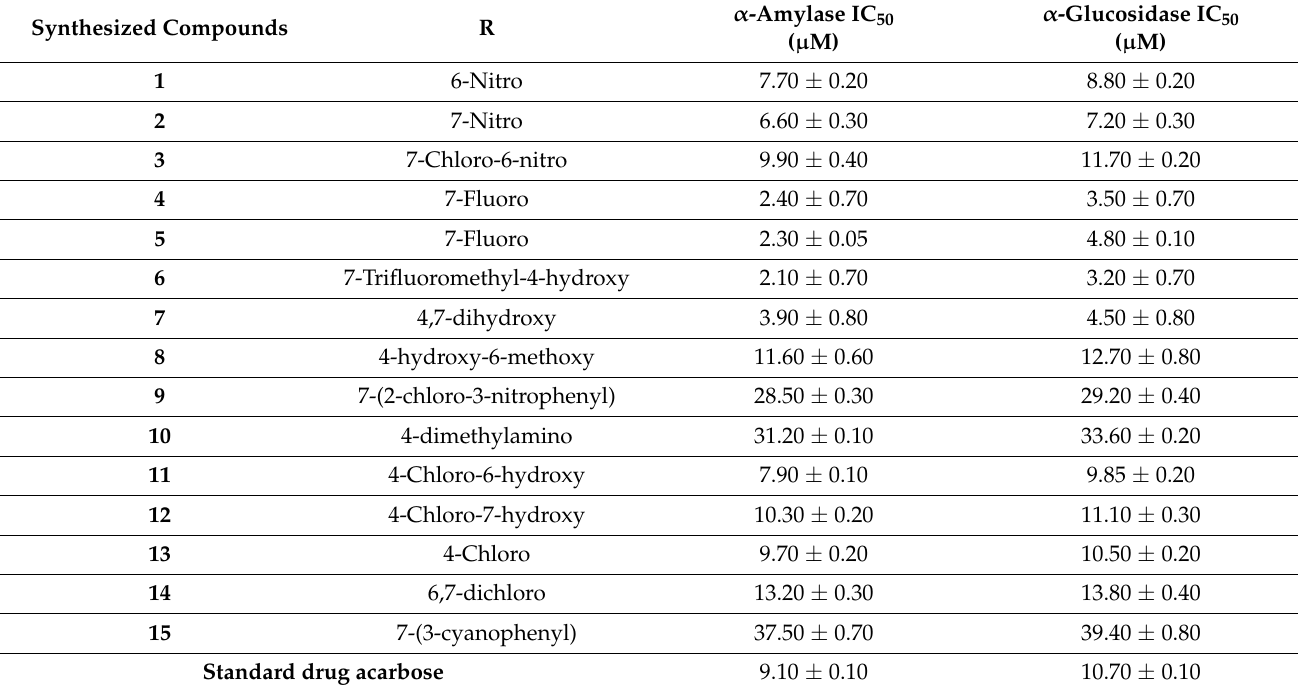
substituents on the phenyl ring and their potency with the standard drug acarbose. Table 1. Thiazolidinedione-based benzothiazole derivatives 1 – 15 with biological inhibitory profile.